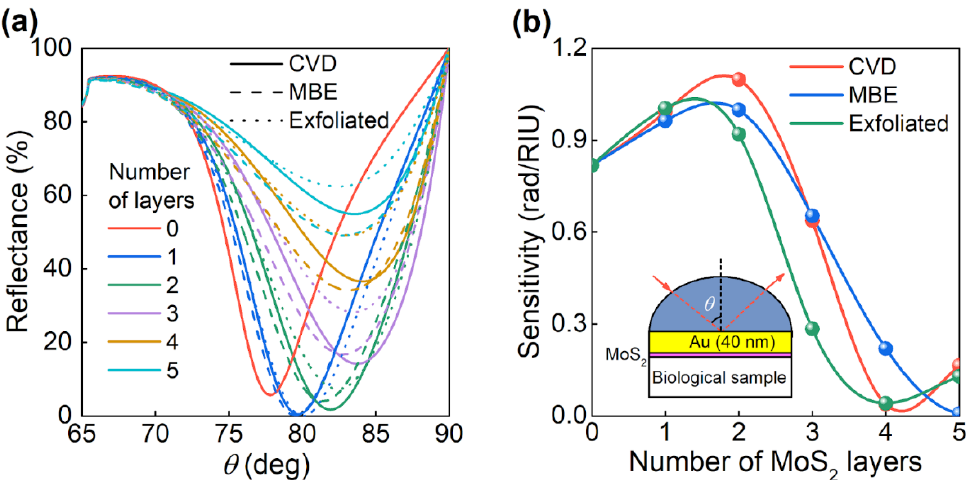
Figure 5. Surface plasmonic resonance (SPR) sensor based on SiO 2 /Au (40 nm) chip with CVD, MBE and exfoliated MoS 2 . ( a ) The reflectance of SPR sensor for different layer numbers of CVD, MBE, and exfoliated MoS 2 . ( b ) The dependence of the SPR sensor sensitivity on the MoS 2 number of layers. The inset is a scheme of an SPR sensor.